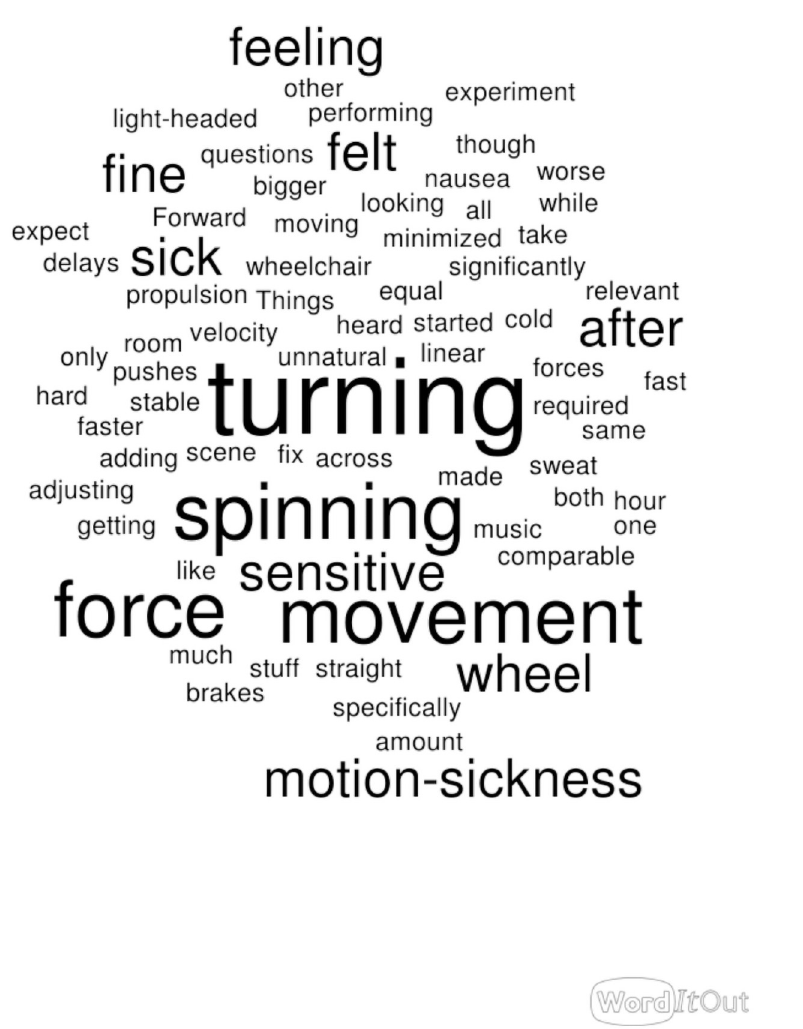
Fig 10. Word cloud for VR_sysI (made using